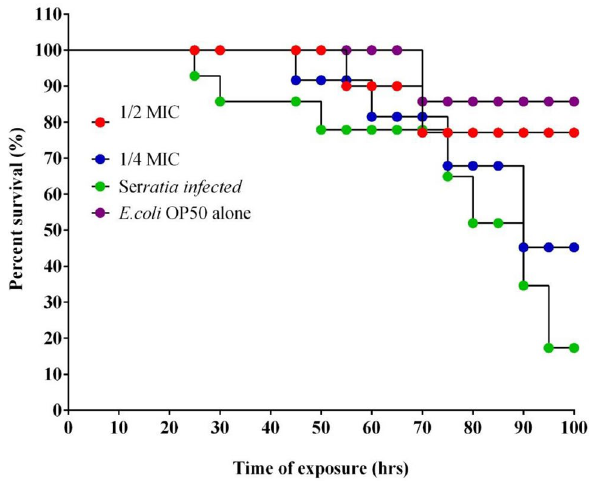
Figure 8. Survival curves of C. elegans of quercetin treated and untreated groups. The survival rates were subjected to Kaplan–Meier survival analysis to prepare survival curves and the data were compared with untreated worms. P values ≤ 0.05 were considered as significant.